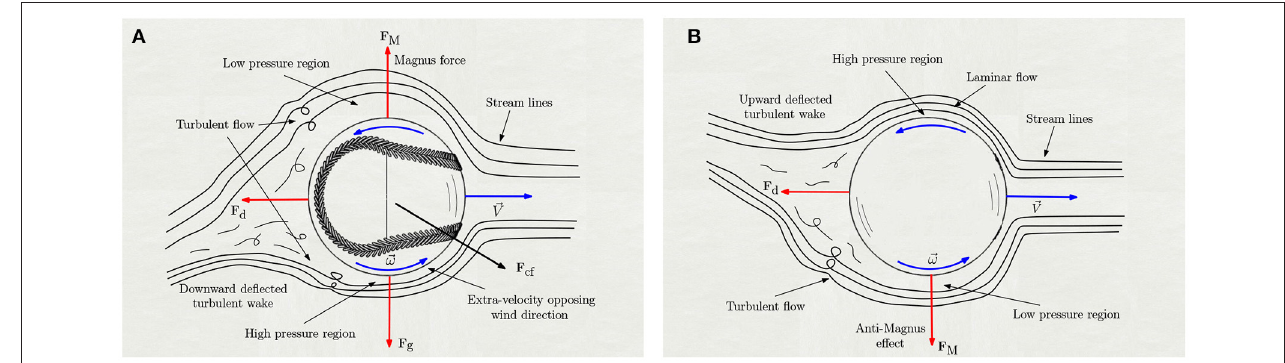
FIGURE 3 | Scheme of the possible ways of causing a Magnus force. (A) The common Magnus force. Modified from Aguirre-López et al. [5]. (B) The reverse Magnus